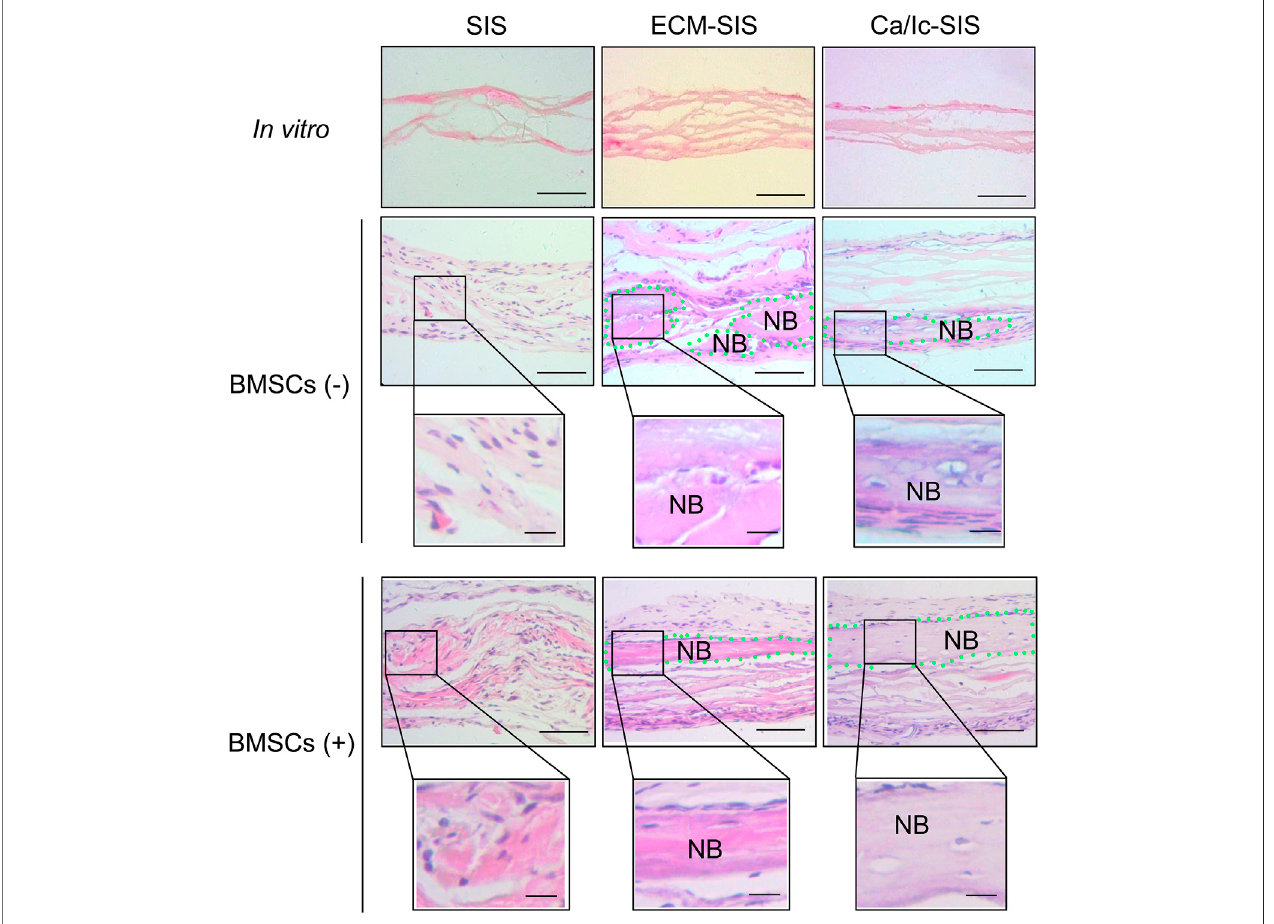
FIGURE 4 | Representative histological images (hematoxylin-eosin staining) showed various bone regenerative effects of the six scaffolds (SIS, ECM-SIS, Ca/Ic- SIS, SIS + BMSCs, ECM-SIS + BMSCs, and Ca/Ic-SIS + BMSCs) after 8 weeks. Considerable formation of the new bone was detected in the ECM-SIS and Ca/Ic-SIS groups (seeded with or without BMSCs). Green dotted region represented newly formed bone (NB). Scale bar: 100 μ m.